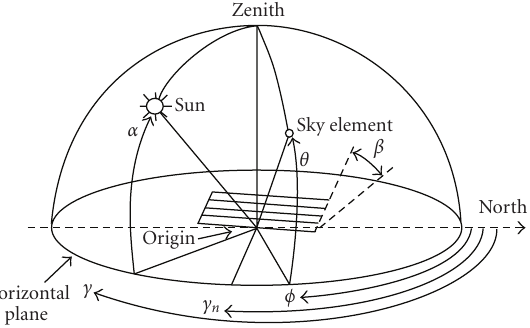
Figure 2: Definition of solar and sky